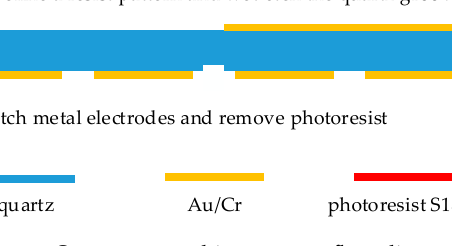
Figure 3. Quartz wet-etching process flow diagram.